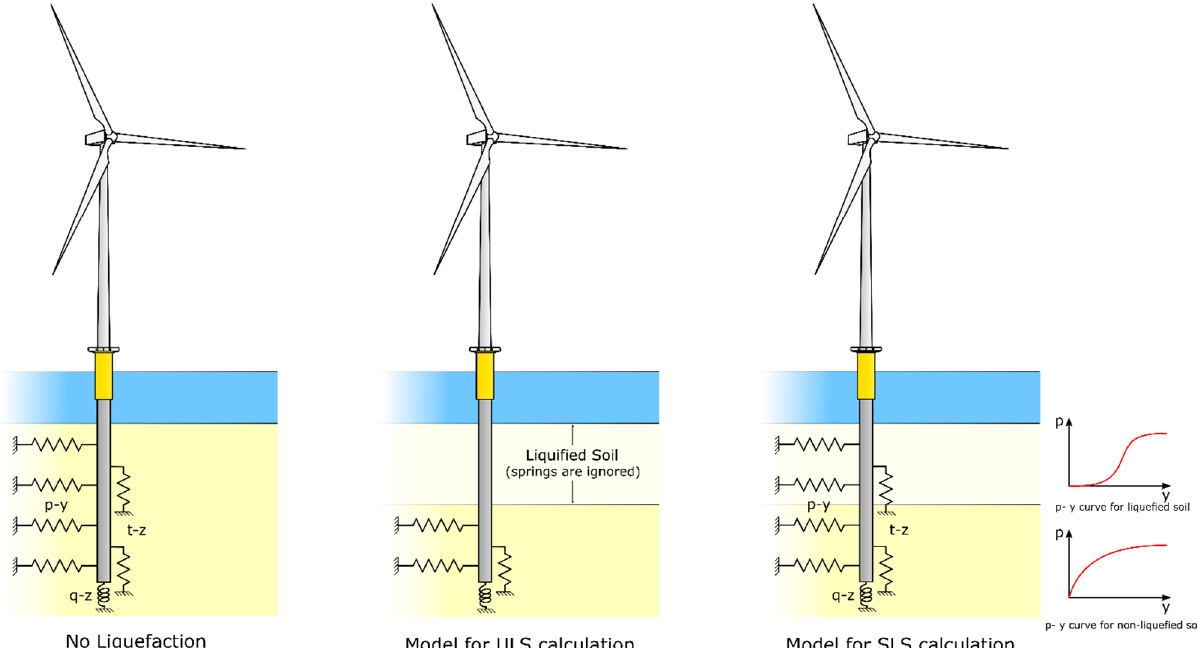
Figure 36. Winkler approach for the simulation of soil–structure interaction. Each spring is defined by a non-linear spring known as p–y , whose shape depends on the strength and stiffness of the material.